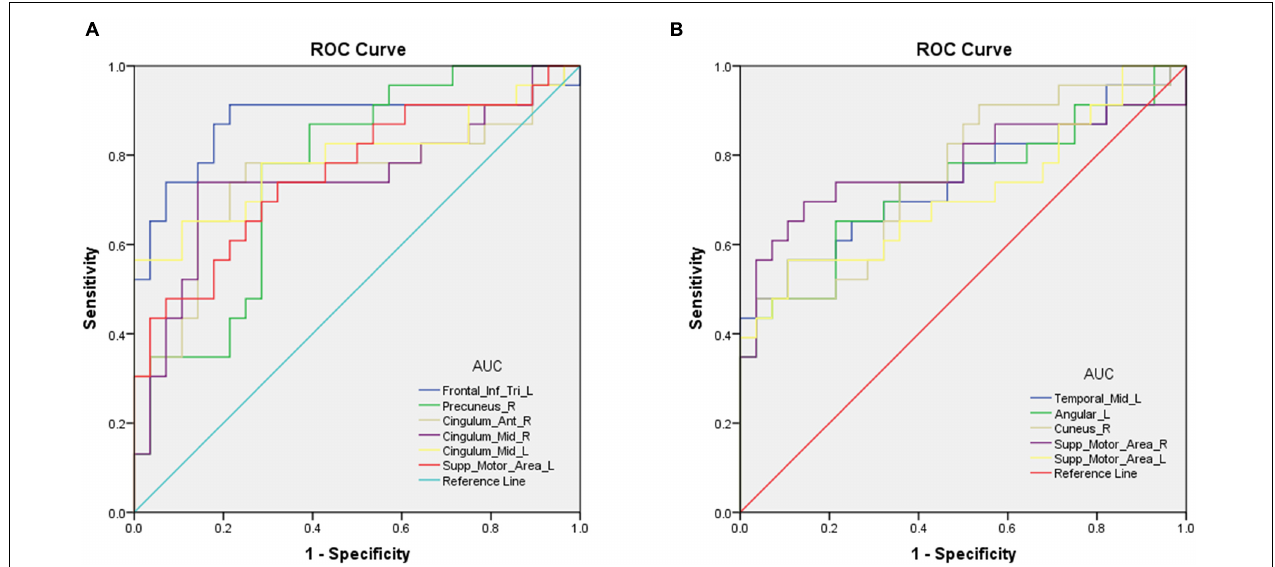
FIGURE 2 | Receiver operating characteristic curve analysis of the mean longFCD (A) and IFCD (B) values for altered brain regions. (A) ROC curve analysis of the gFCD values for altered brain regions. The area under the ROC curve were 0.876 ( P < 0.001; 95% CI: 0.762–0.990) for Frontal_Inf_Tri_L; Precuneus_R 0.762 ( P = 0.001; 95% CI: 0.632–0.893), Cingulum_Ant_R 0.747 ( P = 0.003; 95% CI: 0.599–0.894); Cingulum_Mid_R 0.747 ( P = 0.003; 95% CI: 0.601–0.893), Cingulum_Mid_L 0.792 ( P < 0.001; 95% CI: 0.656–0.928), and Supp_Motor_Area_L 0.761 ( P = 0.001; 95% CI: 0.625–0.896). (B) ROC curve analysis of the IFCD values for altered brain regions. The area under the ROC curve were 0.744 ( P = 0.003; 95% CI: 0.600–0.887) for Temporal_Mid_L, Angular_L 0.733 ( P = 0.005; 95% CI: 0.588–0.878), Cuneus_R 0.758 ( P = 0.002; 95% CI: 0.623–0.892), Supp_Motor_Area_R 0.778 ( P = 0.001; 95% CI: 0.635–0.921), and Supp_Motor_Area_L 0.713 ( P = 0.010; 95% CI: 0.563–0.862). AUC, area under the curve; IFCD, short-range functional connectivity density; longFCD, long-range functional connectivity density; ROC, receiver operating characteristic.